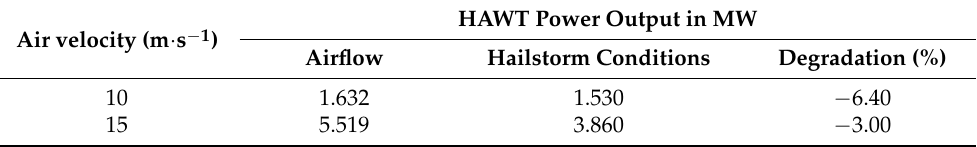
Table 3. Power output of a three-bladed HAWT with blades constructed by NREL S809 airfoil in air- flow and hailstorm conditions, calculated by ANSYS Fluent 16.0 [42] and its percentage